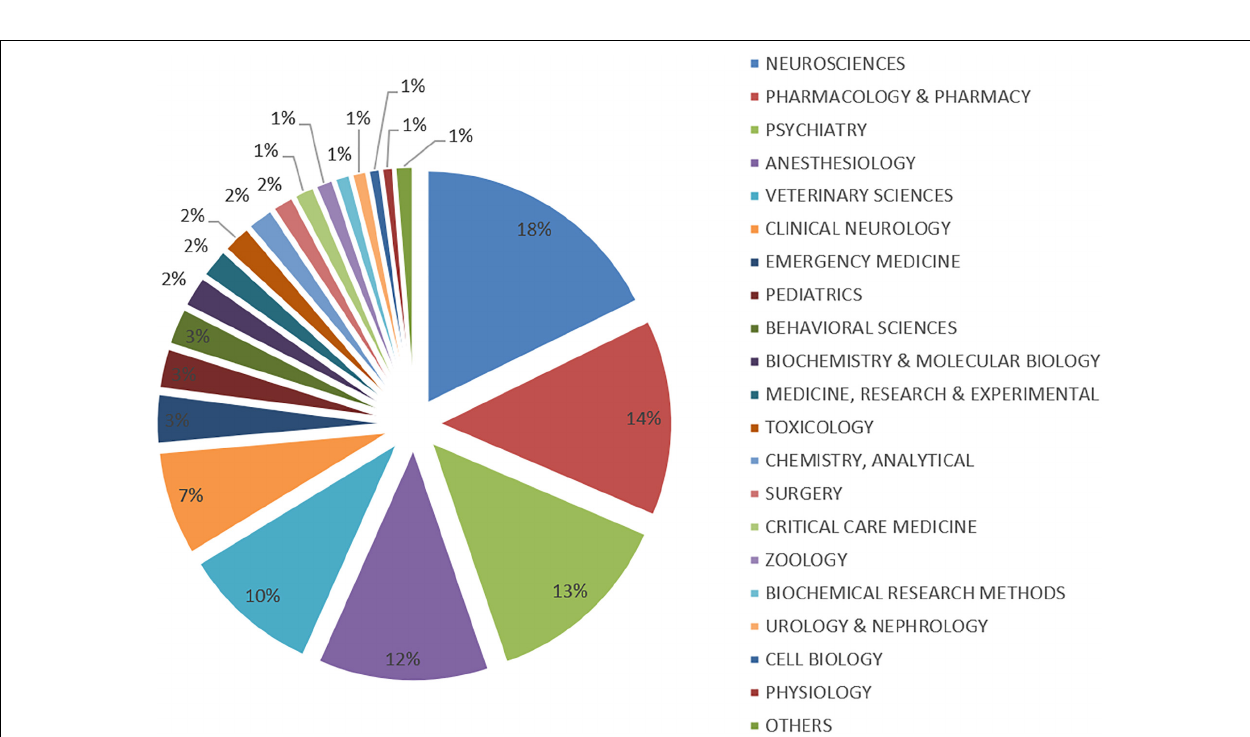
FIGURE 2 | The articles published by different research institutions. The blue bar graph represents the number of articles published by each institution, the red line graph represents the average number of citations per article, and the gray line graph represents the H-index of each institution.